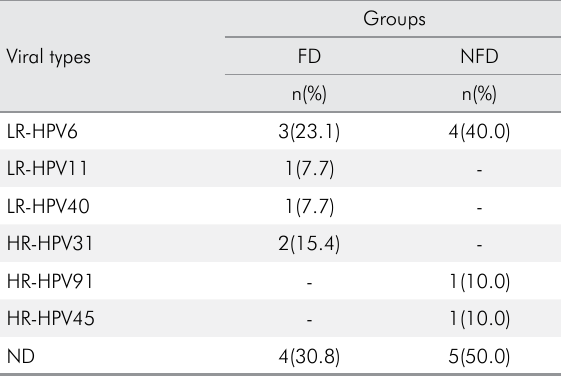
Table. Distribution of the viral types according to oncogenic